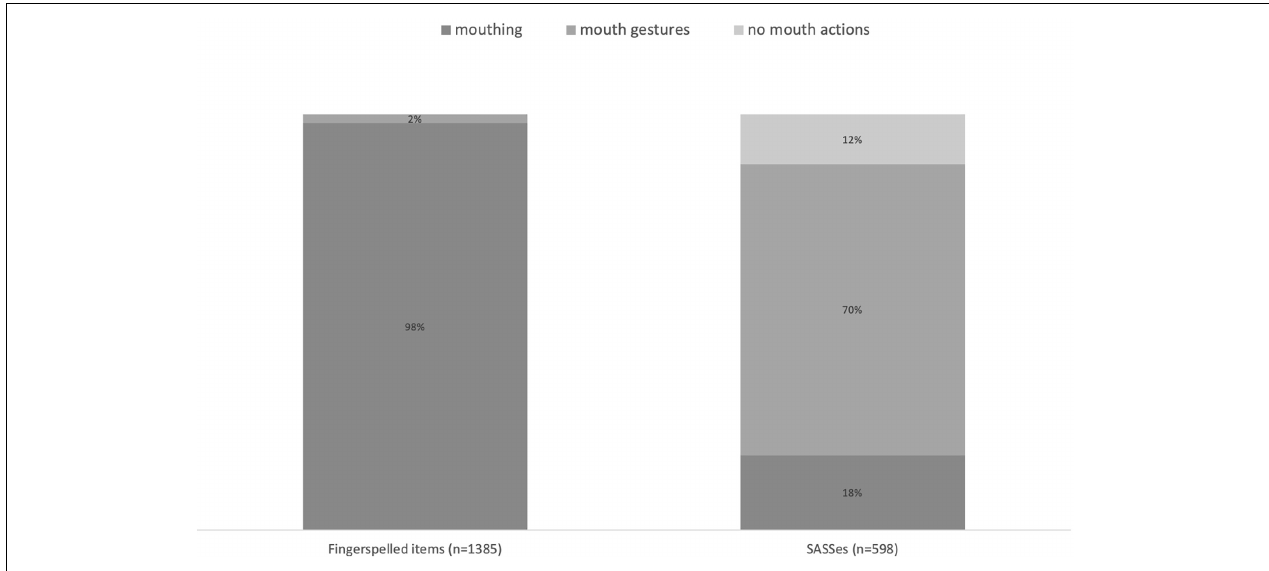
FIGURE 5 | Fingerspelling, SASSes, and